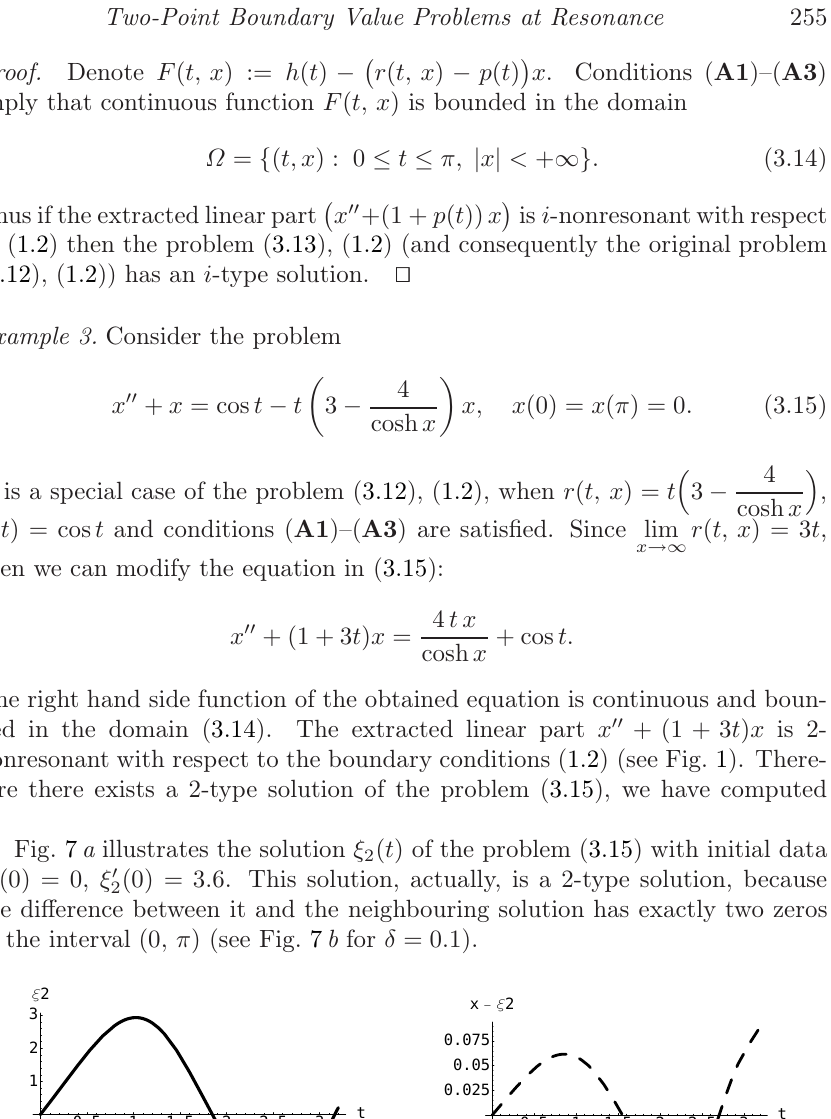
Fig. 8 a , its initial data is given by ξ 1 (0) = 0 , ξ ′ 1 (0) = the difference between it and the neighbouring solution (for δ = ξ 1 ( t )